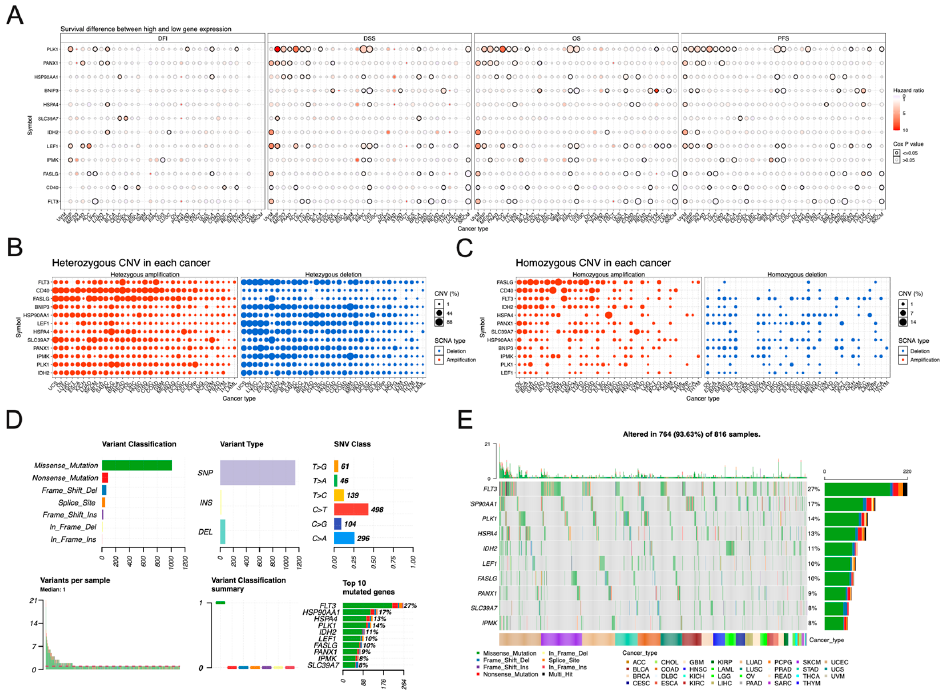
Figure 6. Pan-cancer analysis of necroptosis-associated risk model genes. ( A ) This shows the DFI, DSS, OS, and PFS of these necroptosis risk model genes in pan-cancer. ( B , C ) This shows the CNVs of these necroptosis risk model genes in pan-cancer. ( D , E ) This shows the SNVs of these necroptosis risk model genes in pan-cancer.